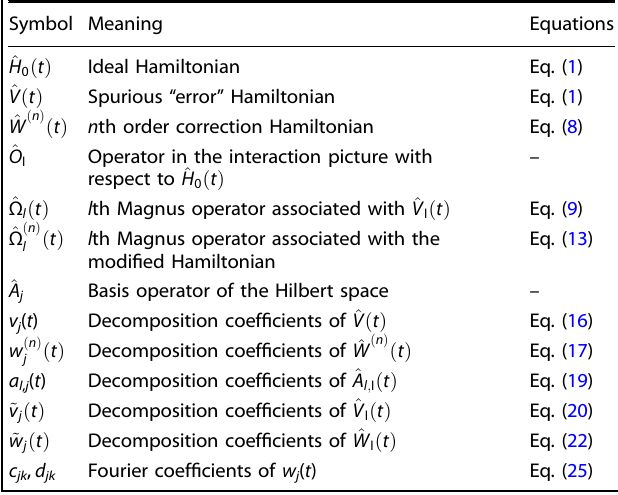
Table 1. De fi nition of the most important symbols. Symbol Meaning